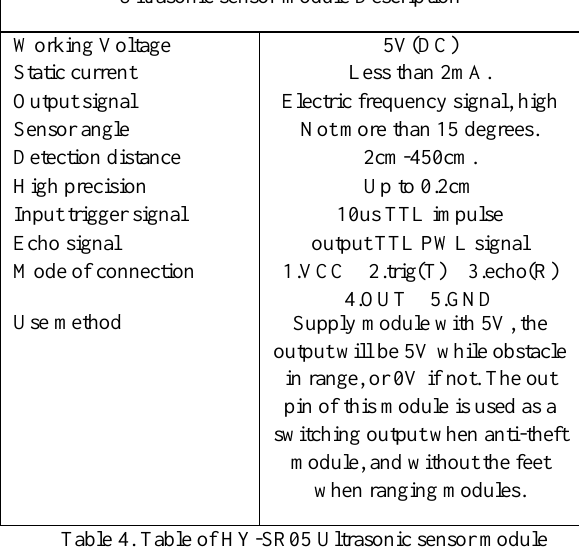
Table 4. Table of HY-SR05 Ultrasonic sensor